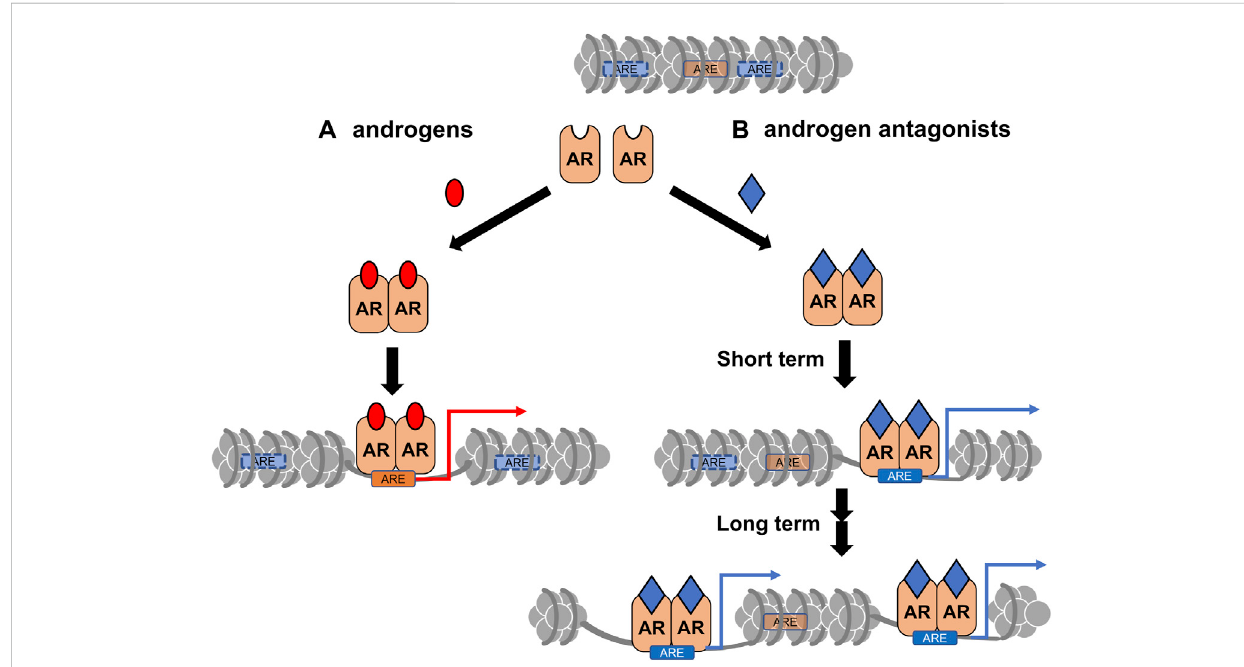
FIGURE 3 A schematic ofdifferentialchromatinremodelingby androgens vs.androgen receptor (AR)antagonists. (A) The canonical remodeling byAR-bound androgens (red). (B) The canonical target sites (ARE with orange) for AR-bound androgens could be closed by chromatin reorganization induced by the antagonist (blue) -bound AR. Cryptic AR target sites (ARE with blue) could be opened for AR binding.